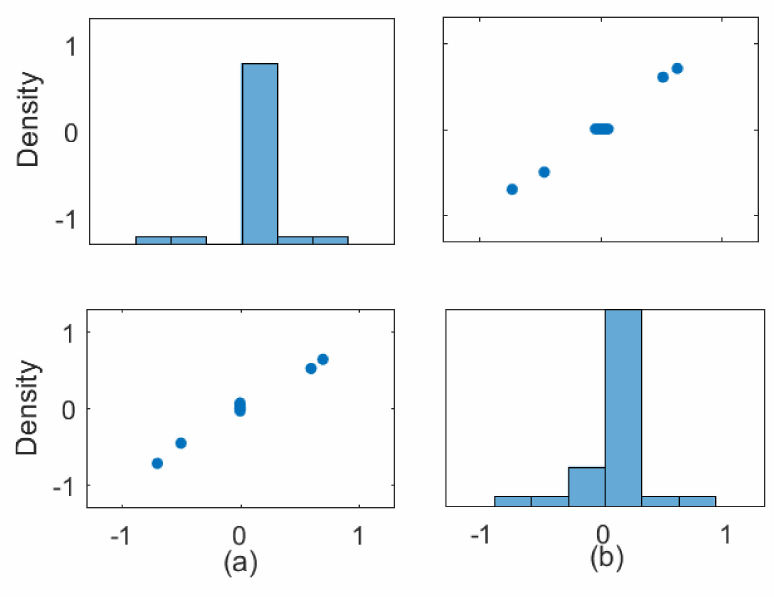
Figure 5. Compare of distribution of w with sparsity: ( a ) sparse value and ( b ) true